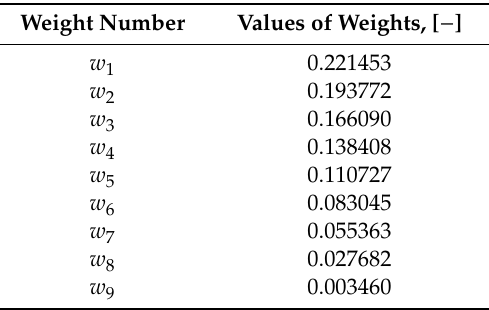
Table 3. Values of weights for calculation of the average carbon content in a sample for the strand 160 mm × 160 mm, at 9 measurement